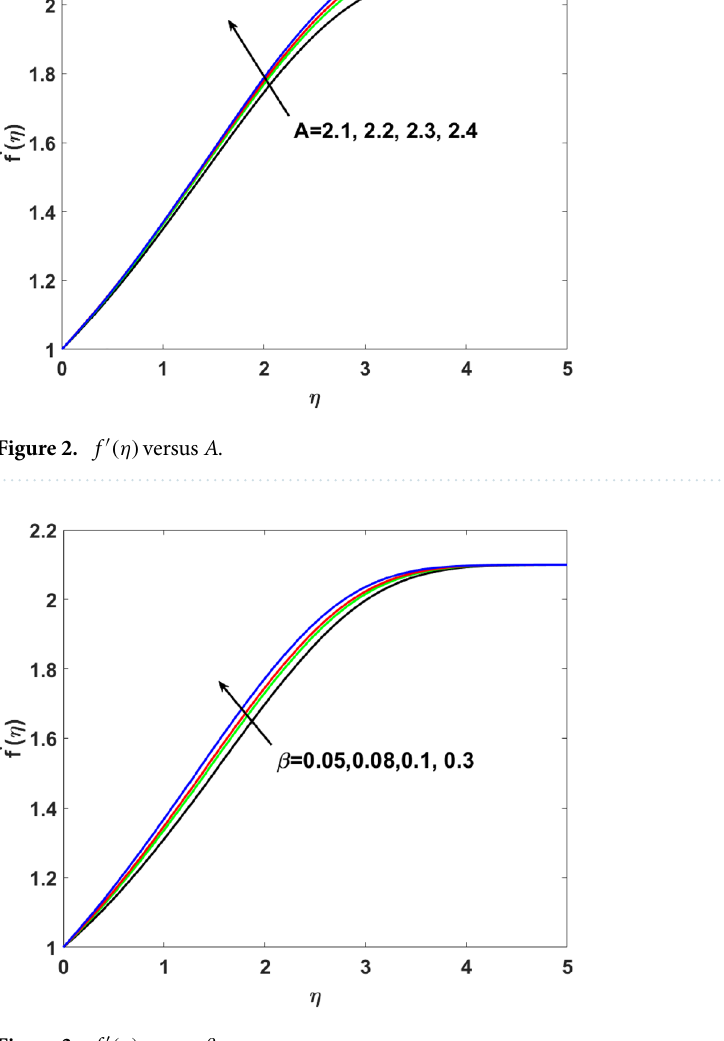
Figure 3. f ′ (η) versus β